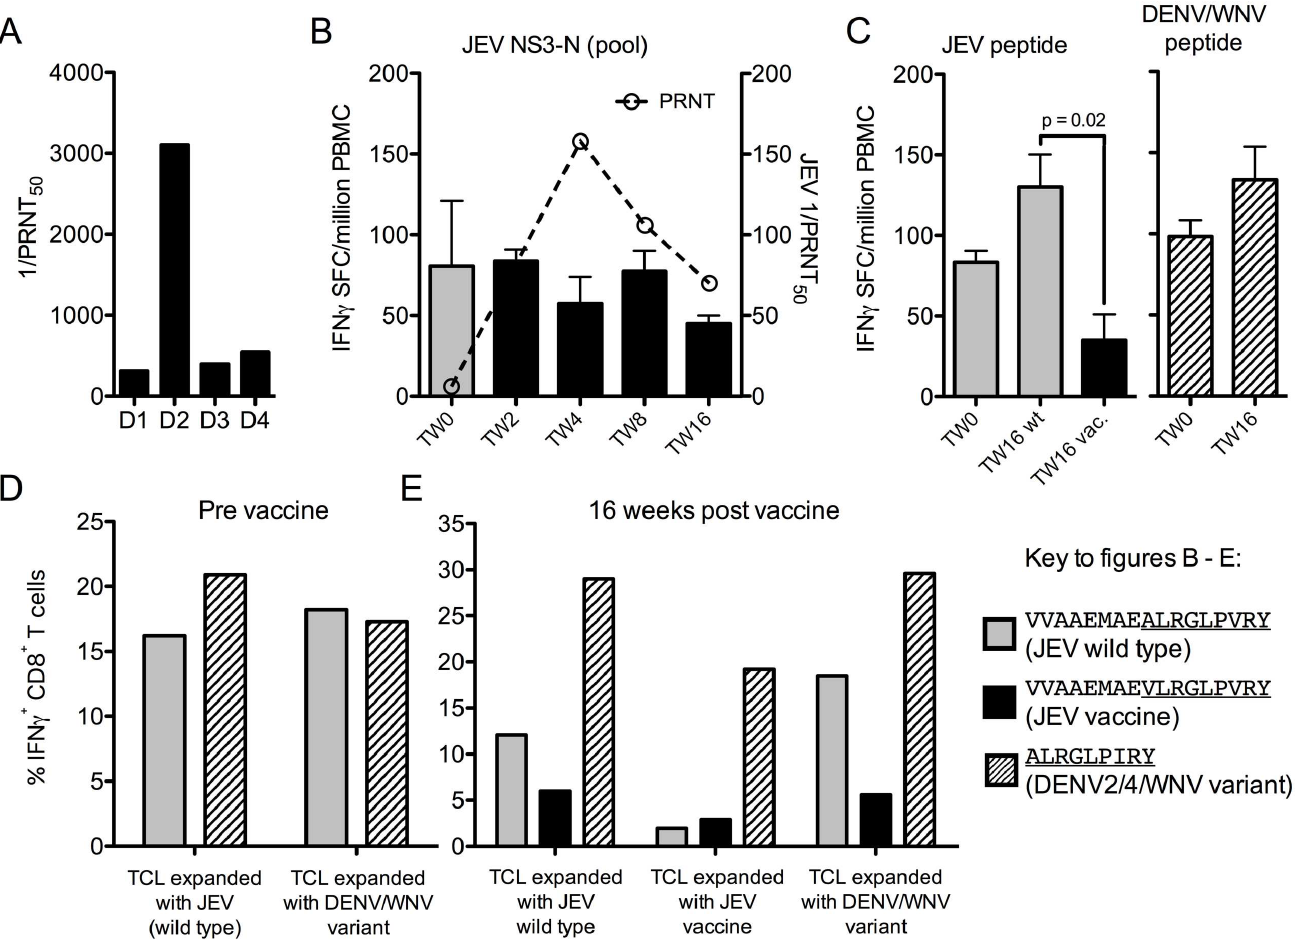
Fig 6. Sub-optimal cross-reactivity of anti-JEV vaccine IFN γ responses in a DENV exposed participant. (A) ReciprocalDENV PRNT 50 were measuredfor all four DENV serotypesby plaqueassay on MK 2 cells. (B) NS3 peptidepool IFN γ -ELISpot and NAb responses duringthe course of the study. (C) IFN γ -ELISpot responses to individualpeptidesat baselineand 16 weeks. Grey bars = wild type pools or peptide(VVAAEMAEALRGLPVRY), black bars = vaccine pools or vaccine peptide(VVAAEMAEVLRGLPVRY), hatched bars = DENV/2/4WNV peptide(VVAAEMAEALRGLPIRY before vaccination,ALRGLPIRY after vaccination). ELISpot data are presented after subtractionof background values; all responses shown met the criteria for a positive assay ( > 50 IFN γ -SFC/10 6 PBMC and doublethe negativecontrol). The IFN γ -ELISpot responseto the JE vaccine peptidewas significantly smaller than the responseto the wild type peptideat the end of the study (pairedt-test). (D) IFN γ responses(percent IFN γ + CD8 + T cells) of short-term T cell lines (TCL) expandedwith JEV and variant peptides before vaccination, and (E) IFN γ responses of TCL 16 weeks after vaccination,tested against both JEV and variant peptides. The peptides used before vaccinationwere VVAAEMAEALRGLPVRY (JEV) and VVAAEMAEALRGLPIRY (WNV, epitopein common with DENV2/4). After vaccination, TCL were expanded with minimalpeptides ALRGLPVRY (JEV) and ALRGLPIRY (DENV2/4, WNV) but tested againstlibrary peptidesVVAAEMAEALRGLPVRY (wild type JEV) and VVAAEMAEVLRGLPVRY (JE vaccine) in additionto ALRGLPIRY (DENV2/4, WNV).